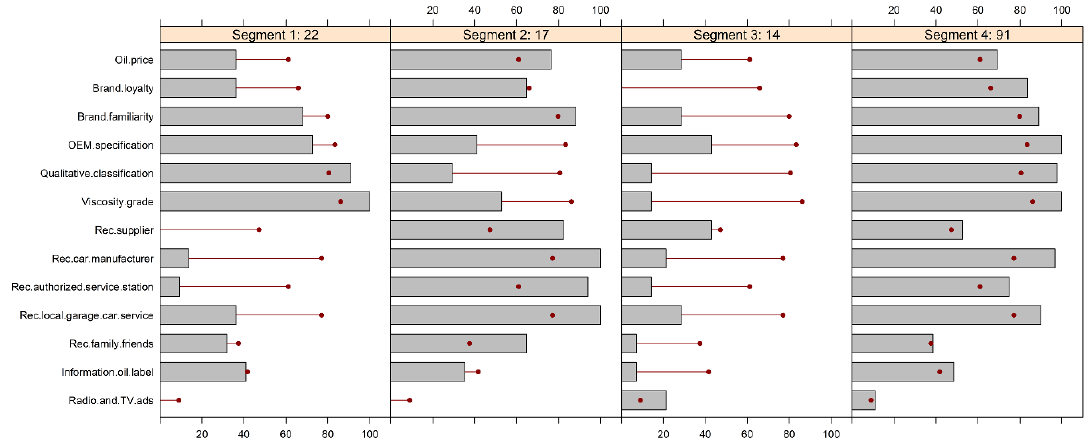
Figure 2. Results of model-based clustering (4 segments).